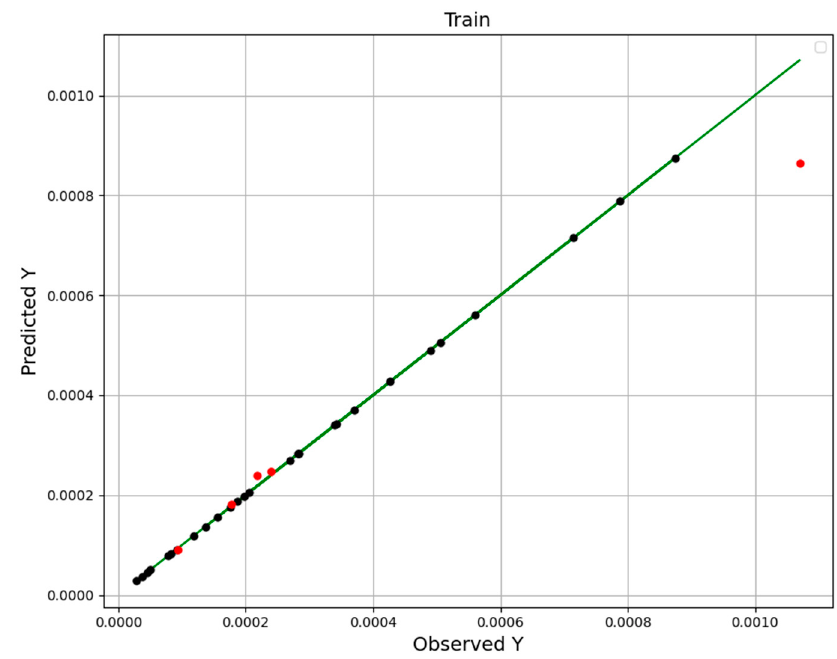
Figure 3. ETR Model: test and train data predictions.